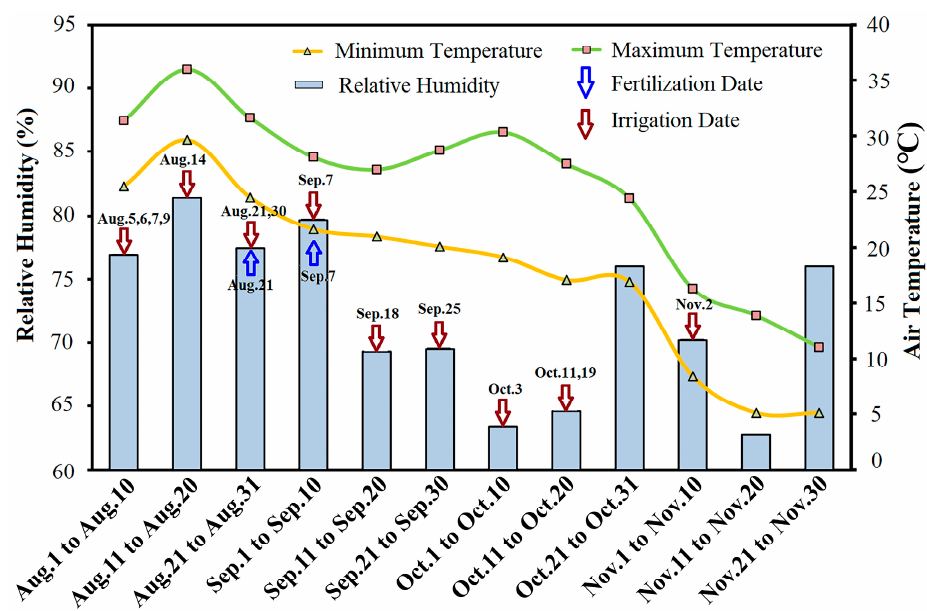
Figure 1. Mean relative humidity, max/min temperature, irrigation and fertilization scheduling in the field experiment during the experimental period. Table 1. Irrigation and N fertilizer rates in six surface drip fertigation (SDF) scenarios.